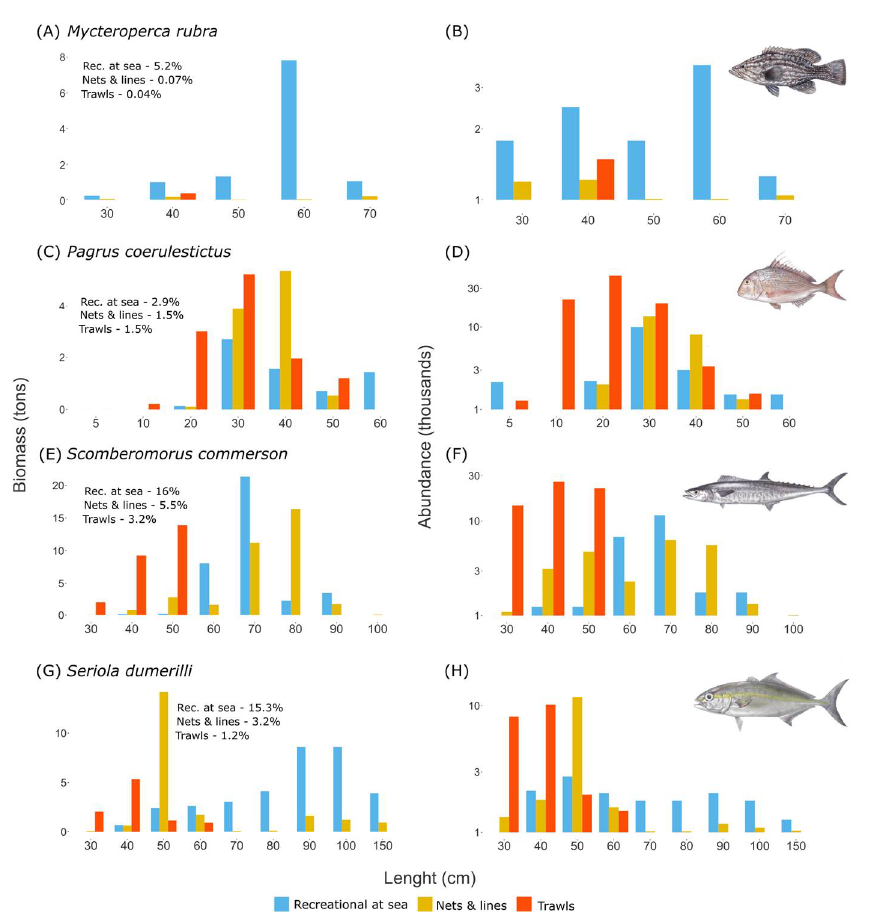
Figure 5. ( A – H ) Common species of the recreational fishing at sea (light blue), nets and long-lines (yellow), and trawl fishing (orange). Figures are divided into biomass and abundance for each species. Species were divided by length into size bins as shown on the x axes. The proportion each species represents from the total catch of the method (in %). For all species results see Figure S6 and Tables S14 and S15.